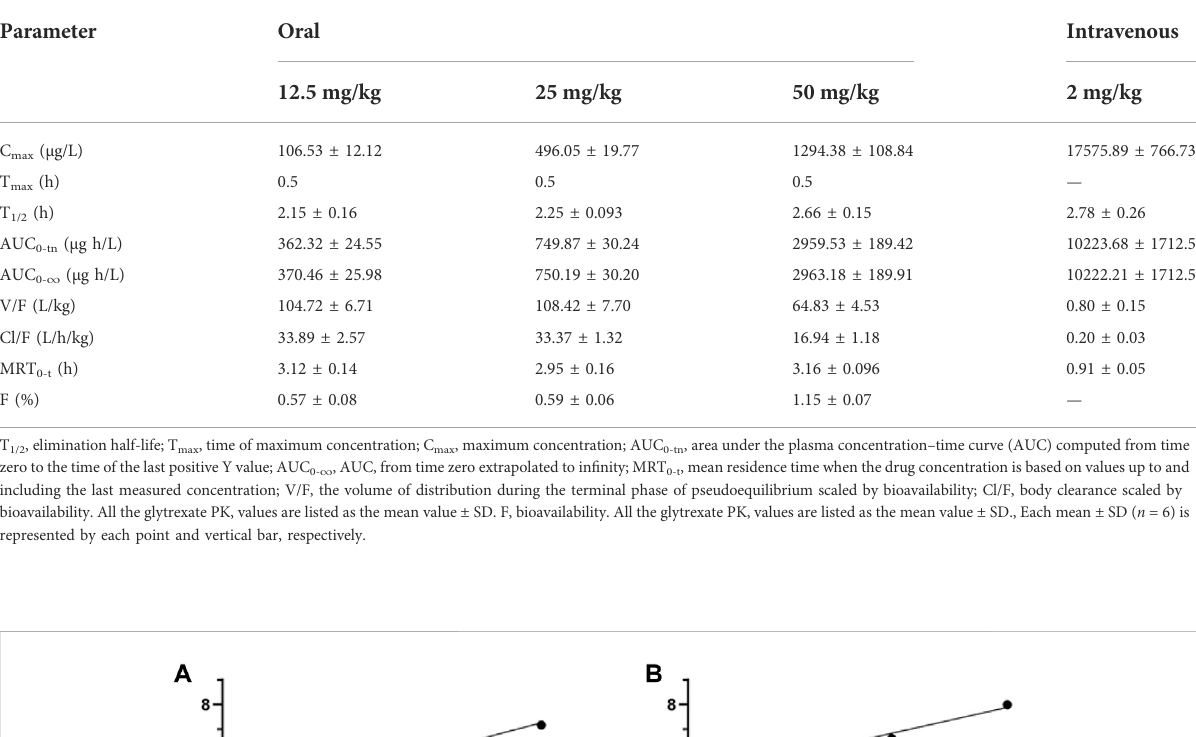
Table 6. Glytrexate reached the maximum plasma concentration (C max ) at approximately 0.5 h. The T 1/2 after oral administration of 12.5, 25, or 50 mg/kg was 2.15 ± 0.16, 2.25 ± 0.093, and 2.66 ± 0.15, respectively. The AUC 0-t of oral administration of 12.5, 25, or 50 mg/kg was 362.32 ± 24.55, 749.87 ± 30.24, and 2959.53 ±